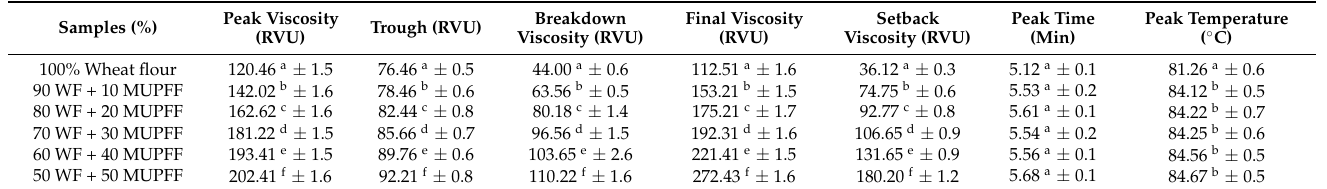
Table 4. Pasting properties of composite flour from wheat flour and unripe pawpaw fruit flour. Samples (%) Peak Viscosity (RVU) Trough (RVU) Breakdown Viscosity (RVU) Final Viscosity (RVU) Setback Viscosity (RVU) Peak Time (Min) Peak Temperature ( ◦ C) 100% Wheat